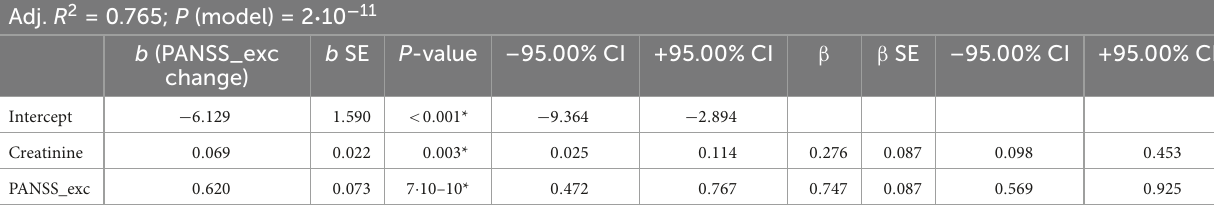
TABLE 2d Results of stepwise linear regression analyses for subscales of the Positive and Negative Syndrome Scale.